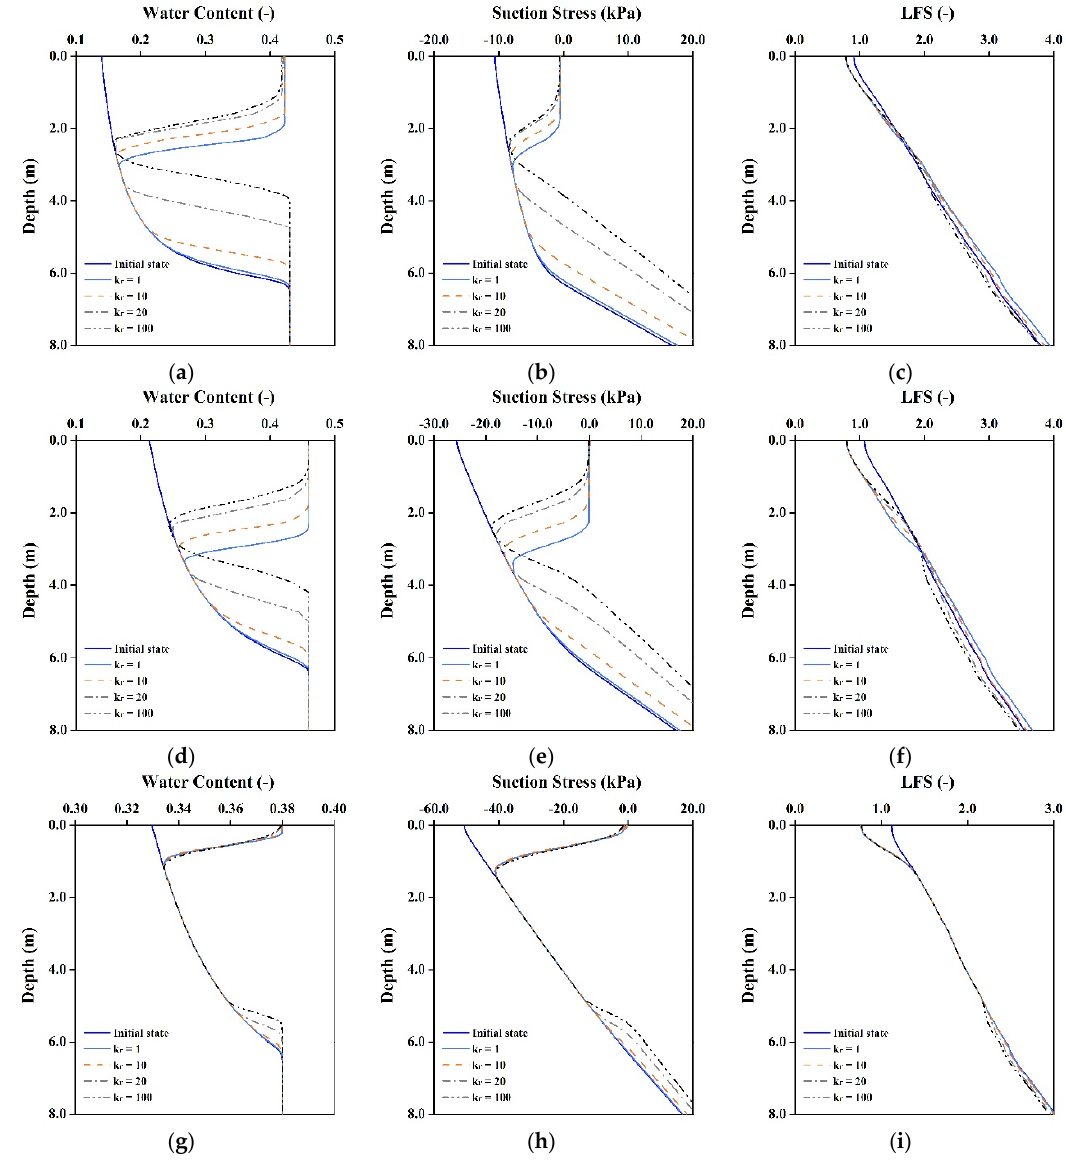
Figure 7. Results of rainfall infiltration in various hydraulic conductivity anisotropy cases at toe of slope (Z ‐ Z’). Changes in ( a , d , g ) Water content; ( b , e , h ) Suction stress; and ( c , f , i ) LFS for loam, silt and clay slopes, respectively. ( a ) Loam; ( b ) Loam; ( c ) Loam; ( d ) Silt; ( e ) Silt; ( f ) Silt; ( g ) Clay; ( h ) Clay; ( i ) Clay.